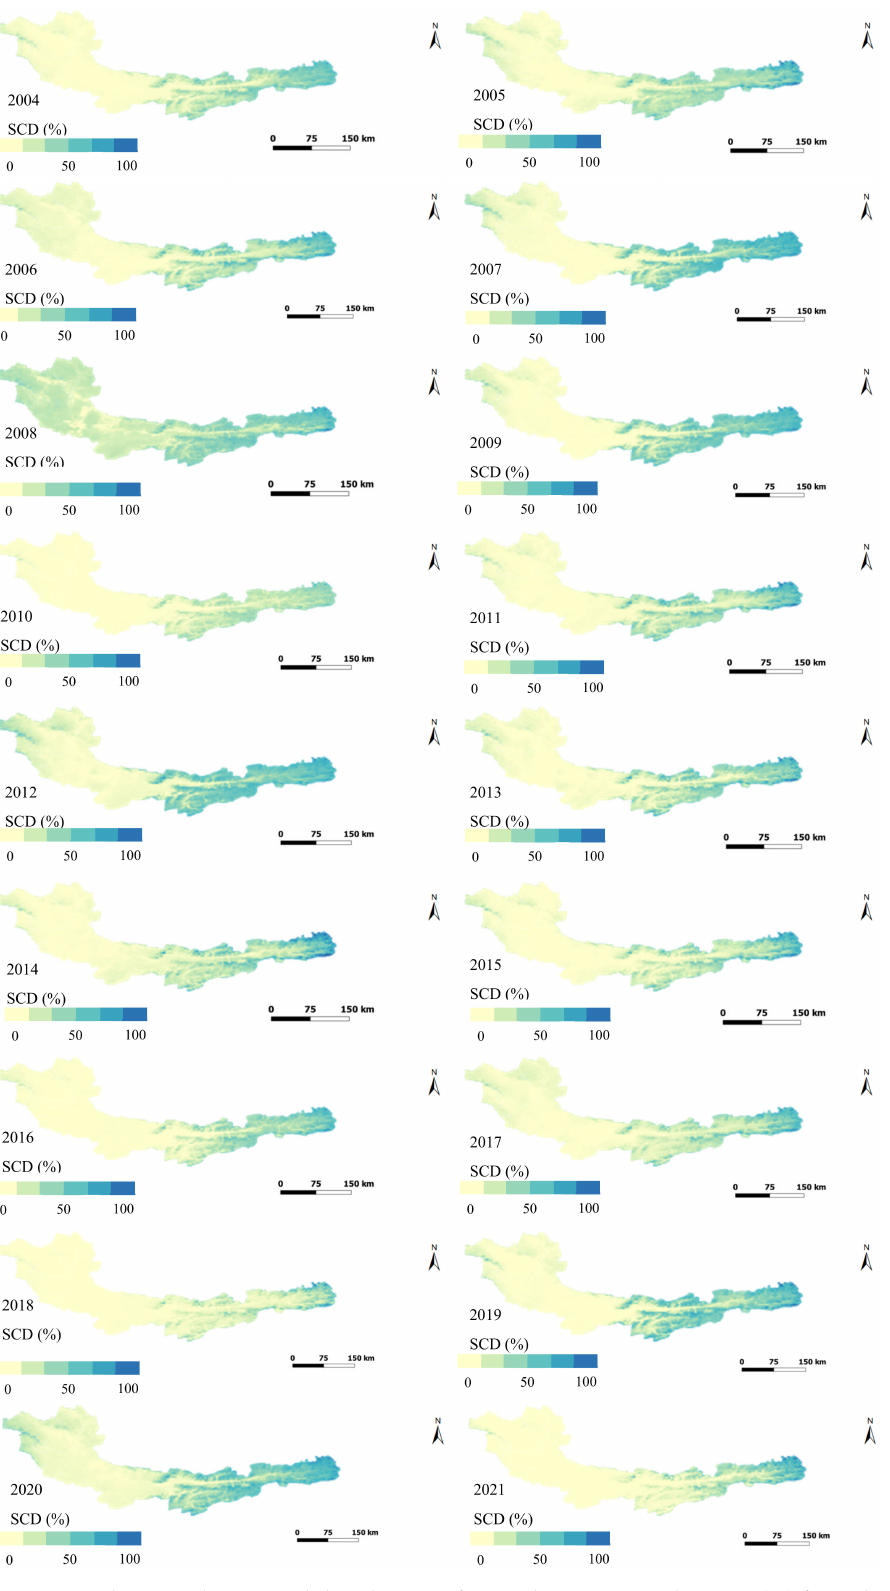
Figure 11. The spatial–temporal distribution of annual snow cover duration (%) from the MODIS (MOD10A1) product derived from GEE in the period of